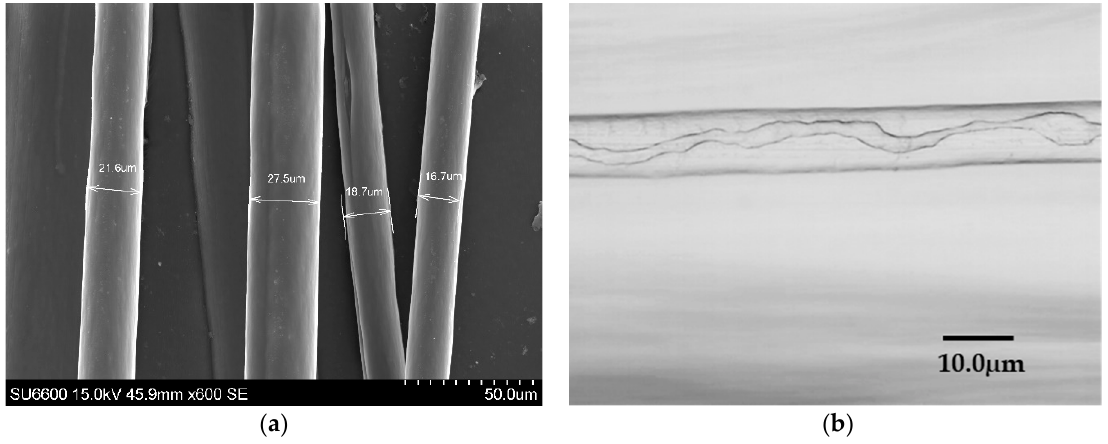
Figure 4. ( a ) The SEM micrograph of electrospun PBLG/PVDF fibers and ( b ) the core–shell